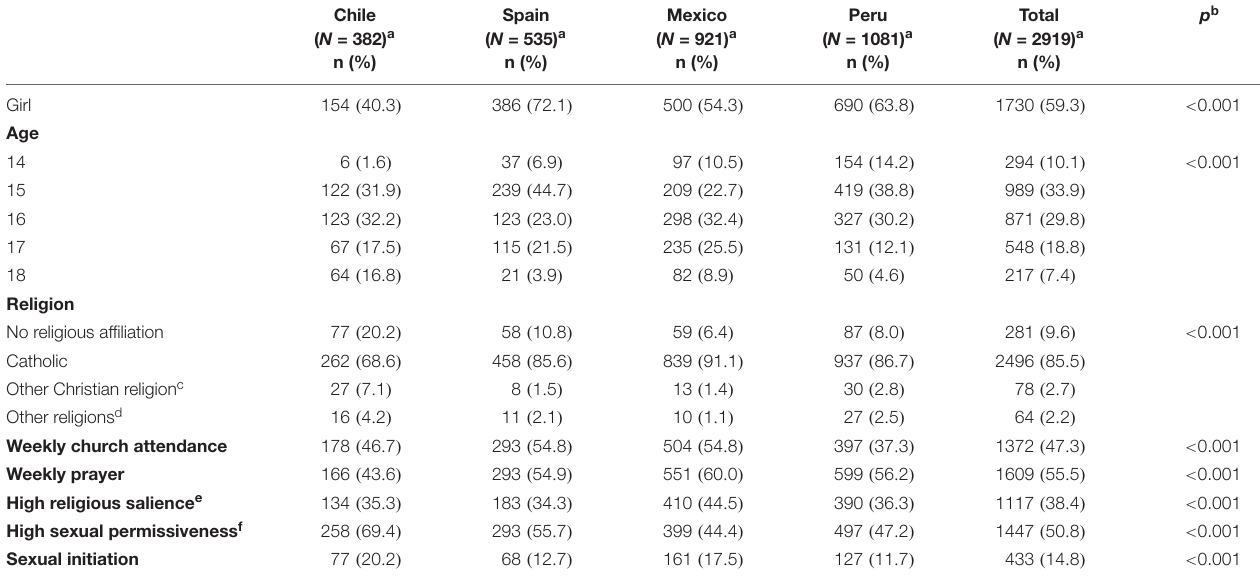
TABLE 1 | Characteristics of the sample.